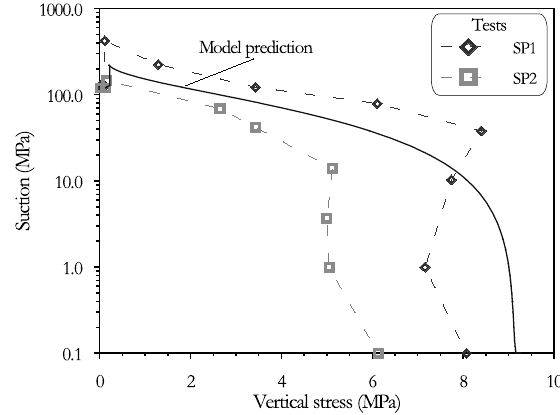
Fig. 7 – Computed stress path for swelling pressure tests using the BBM. SP1 and SP2 experimental results are provided for comparison.